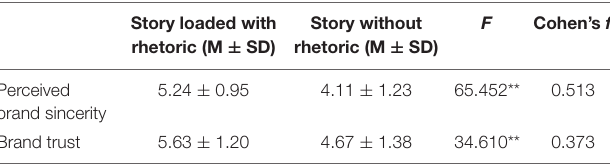
TABLE 3 | Differences in the influence of the three means of persuasion in green brand stories on perceived brand sincerity and brand trust. Story loaded with rhetoric (M ±